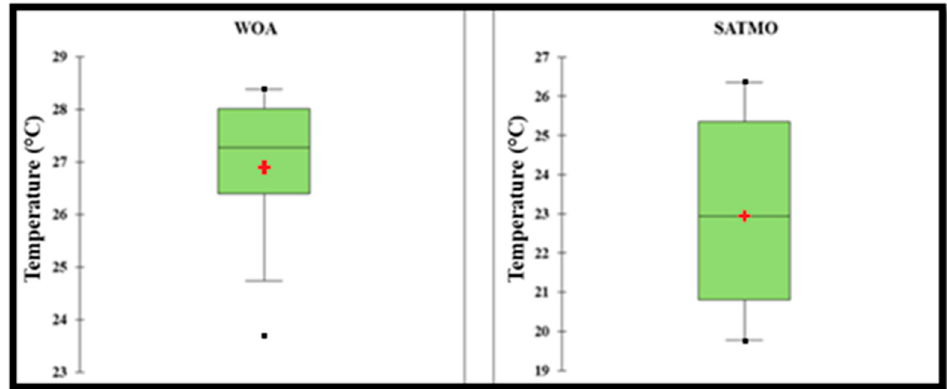
Figure 5. Mean and standard deviation values for World Ocean Atlas (WOA) and Satellite Oceanic Monitoring System (SATMO) databases. The cross indicates the statistical mean, while the dots indicate the minimum and maximum values.